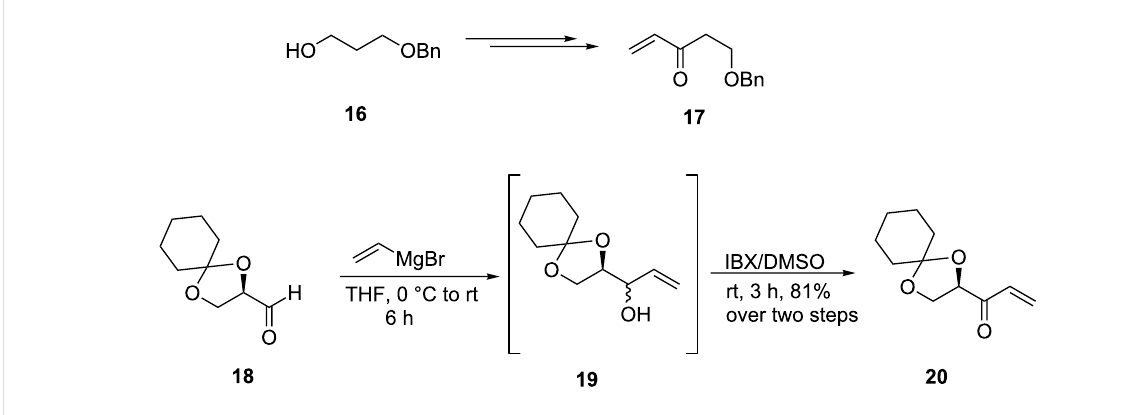
Scheme 3: Synthesis of oxygenated ethyl vinyl ketones.